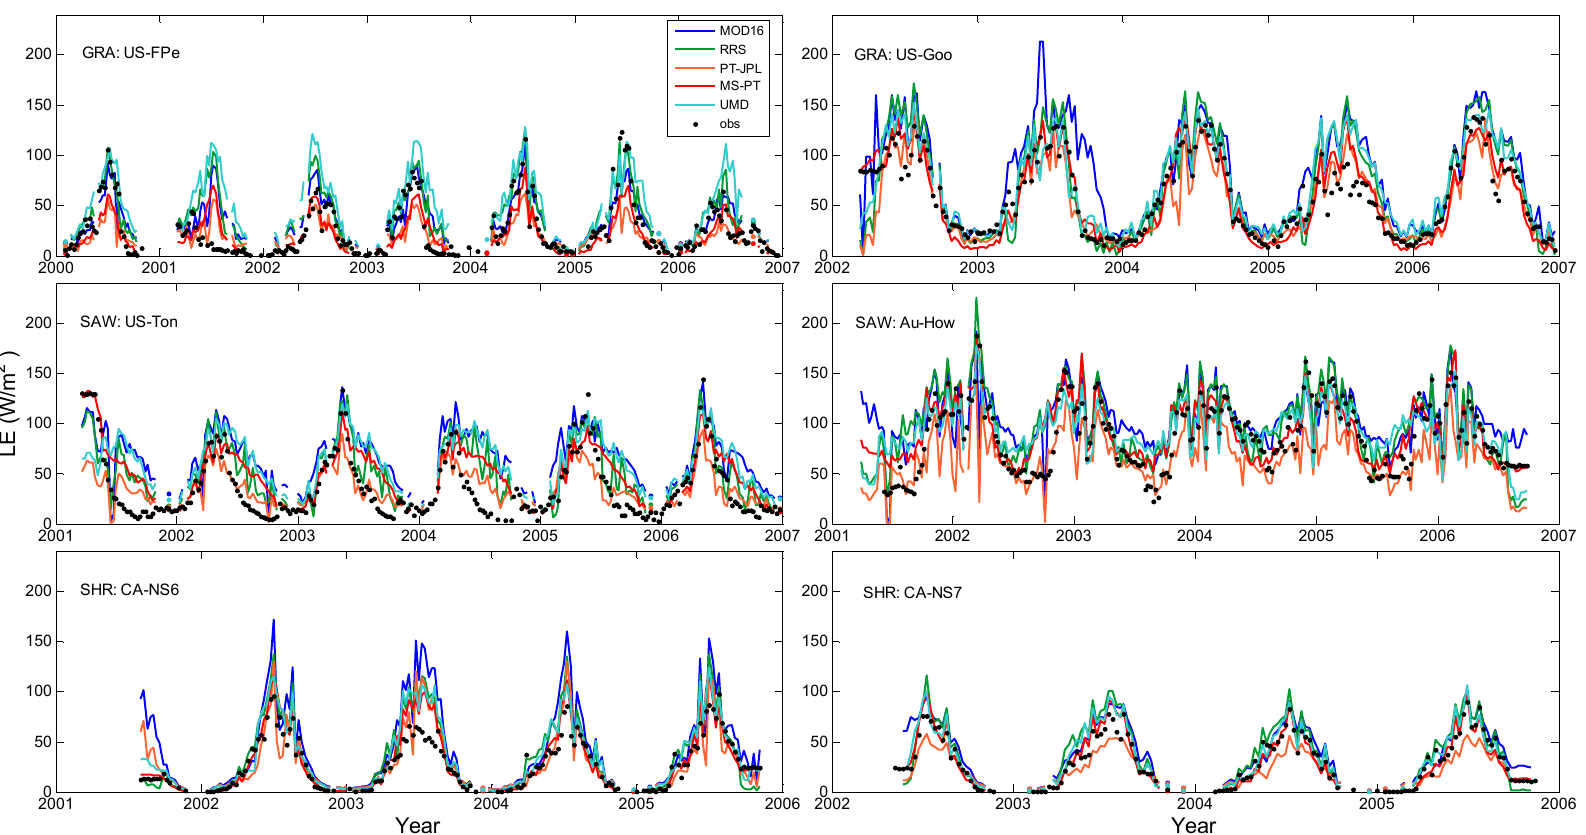
Figure 5. Measured and estimated time series for the 8 day LE average during the period 2000–2007. The GRA sites include US-FPe and US-Goo. The SAW sites include US-Ton and AU-How. The SHR sites include CA-NS6 and CA-NS7. Locations include FPe*—(Fort Peck); Goo*—Goodwin Creek; Ton*—Tonzi Ranch;